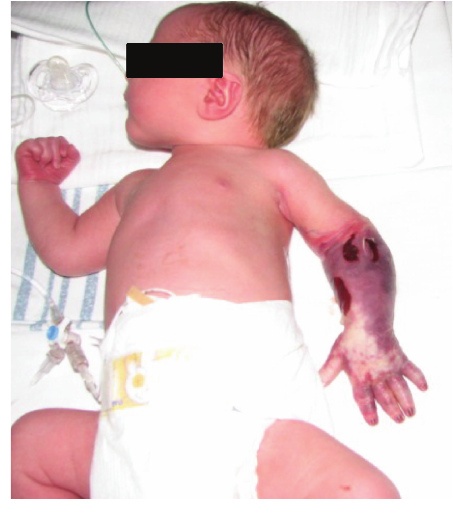
detected in arteria brachialis, radialis, or ulnaris by Doppler ultrasound. A normal signal was